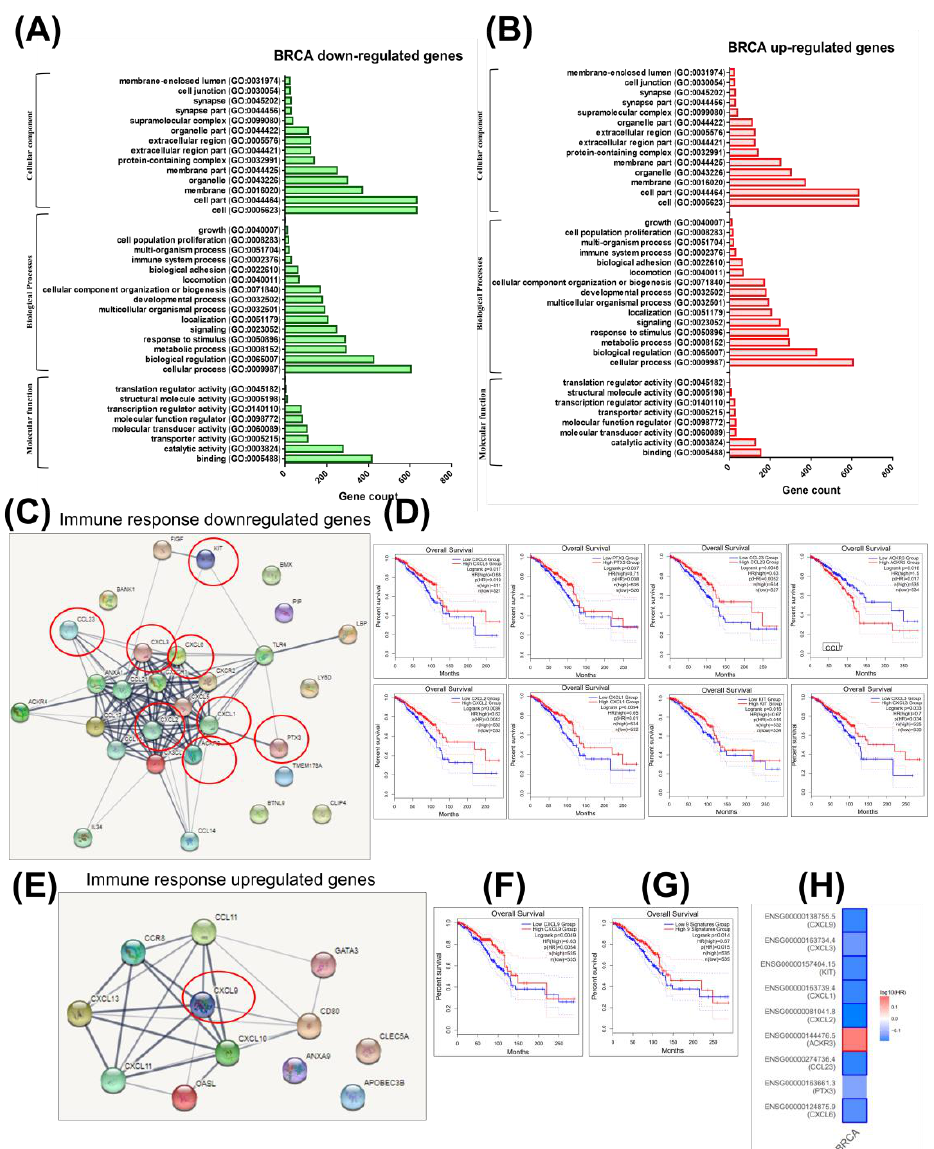
Figure 1. Biological significance of the breast cancer (BRCA)-altered gene expression signatures. ( A ) Gene ontology (GO) analysis for downregulated genes and ( B ) GO analysis for overexpressed/upregulated genes, respectively, using the Panther Gene ontology